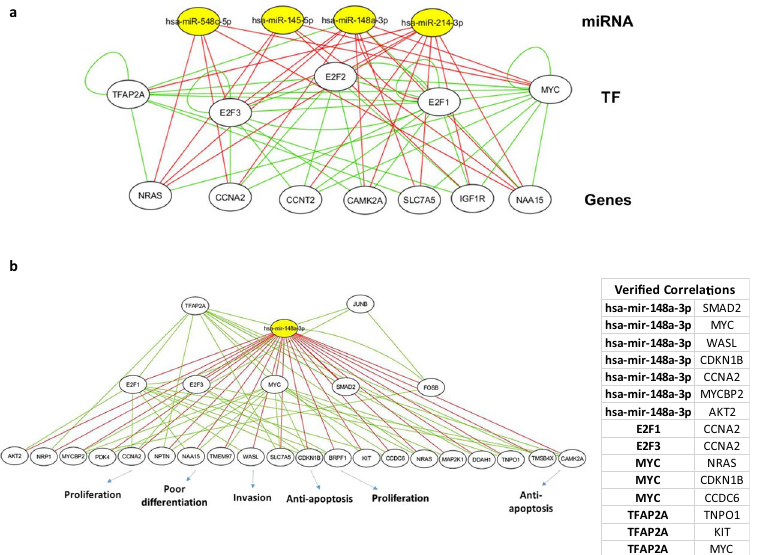
Figure 4. Sub-networks extracted from the HCSC miRNA and TF regulatory relationships. ( a ) Sub-network among the representative hubs. ( b ) The miR-148a sub-network model. Red edges are directed from miRNA, while green edges directed from TF to their